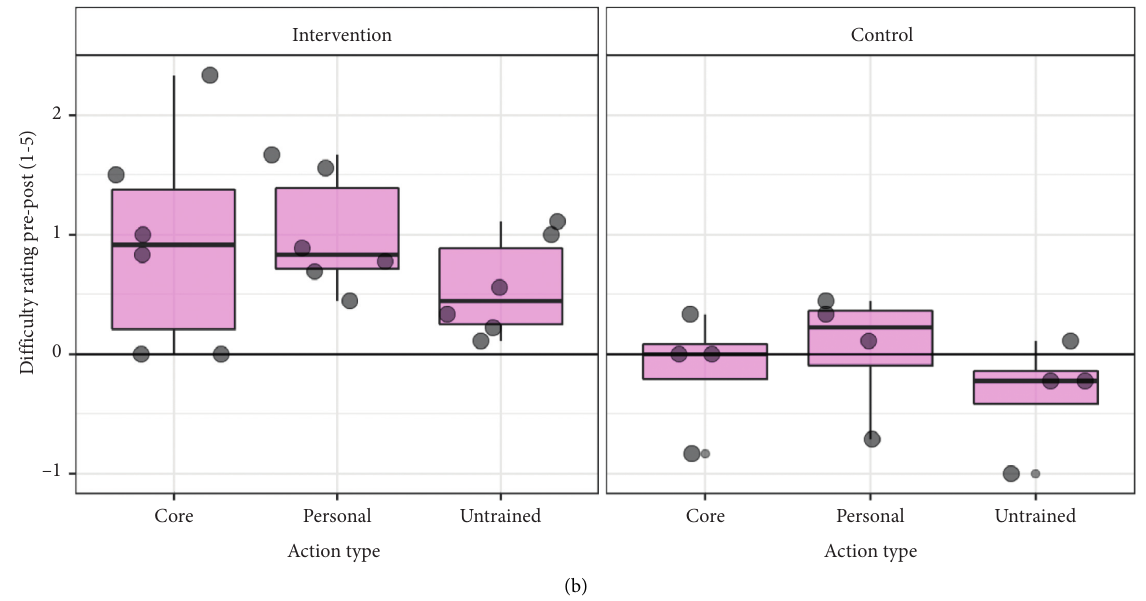
Figure 6: Changes in (a) timed action performance and (b) difficulty ratings in the pilot RCT for the core actions (common across participants) and personally selected trained and untrained actions. Boxes show medians and quartiles with dots representing individual participants. Positive values indicate a postintervention reduction in (a) duration or (b)